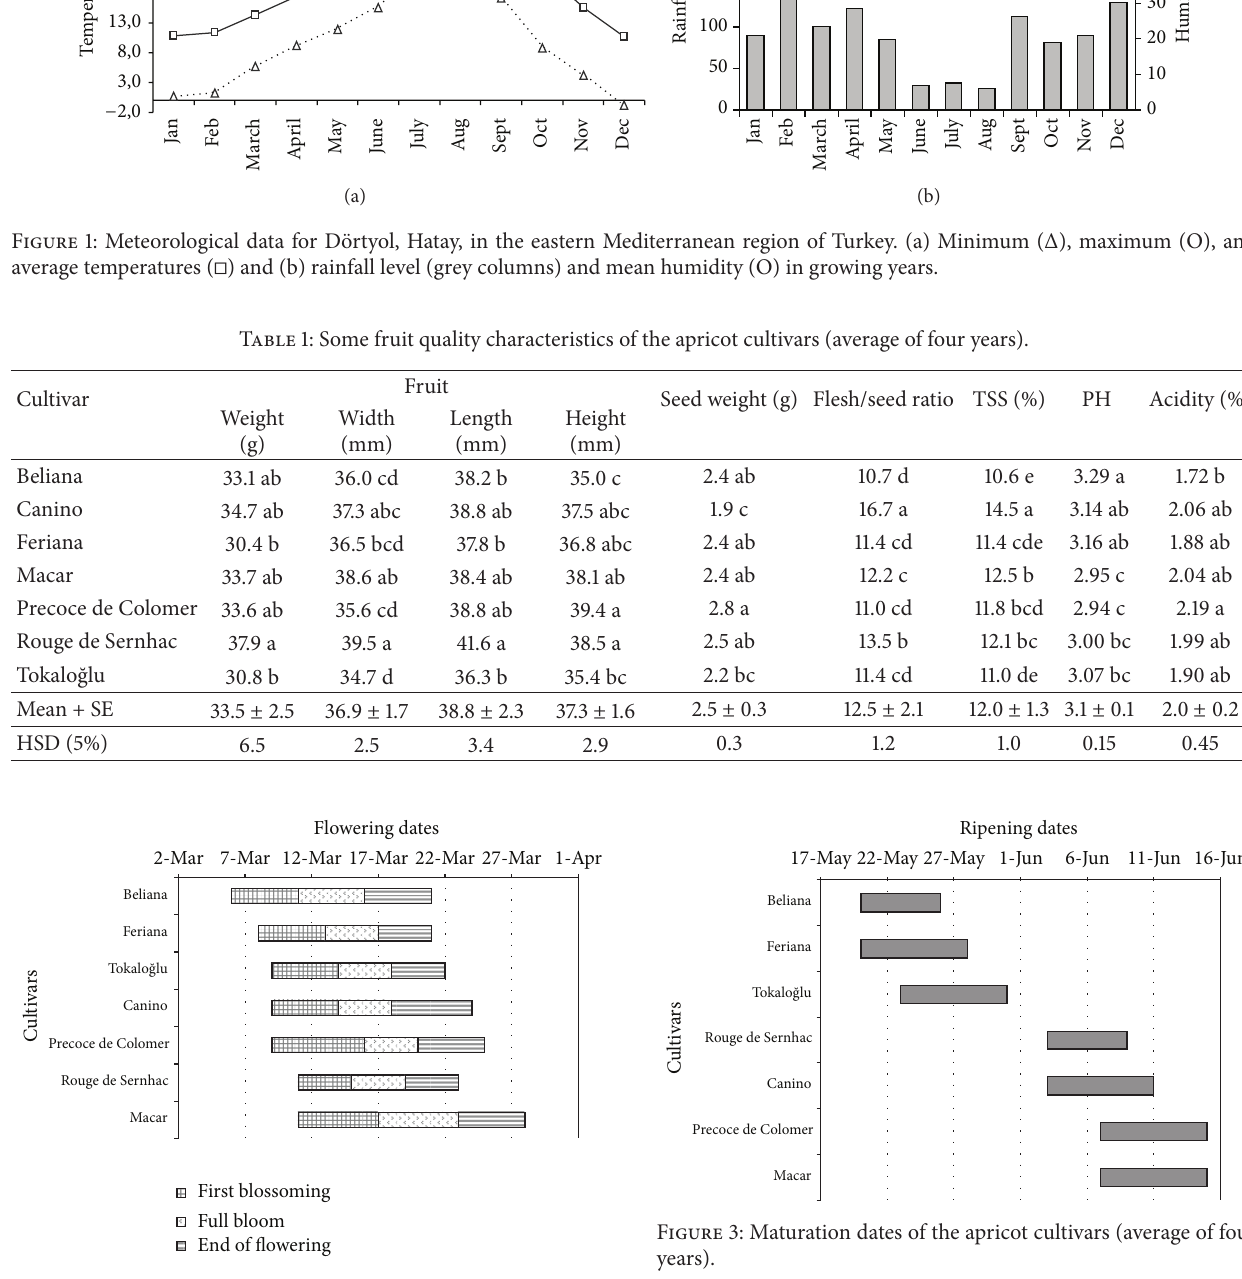
Figure 2: Flowering dates of the apricot cultivars (average of four years).